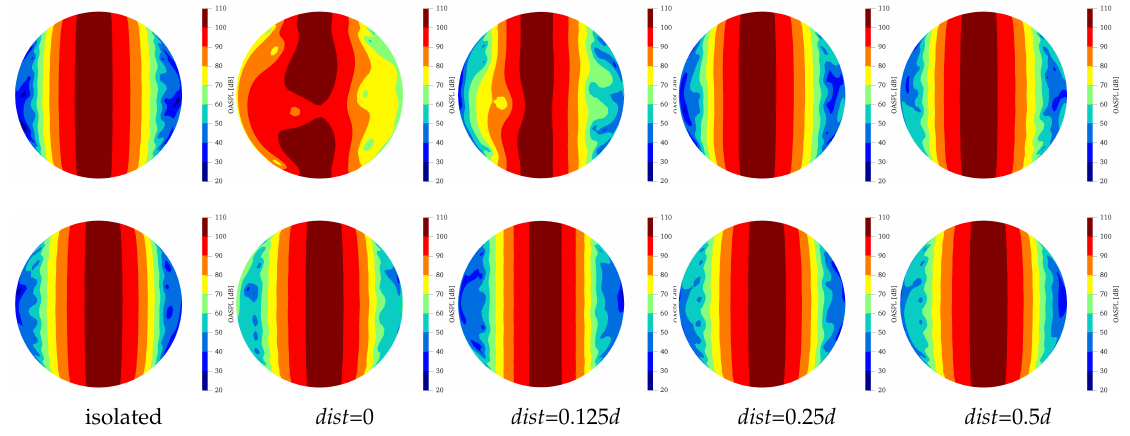
Figure 10. Sound directivity (OASPL) of rotor #1 for the cases dist = {0, 0.125 d , 0.25 d , 0.5 d }. The first row shows the noise sphere from below, the second one from